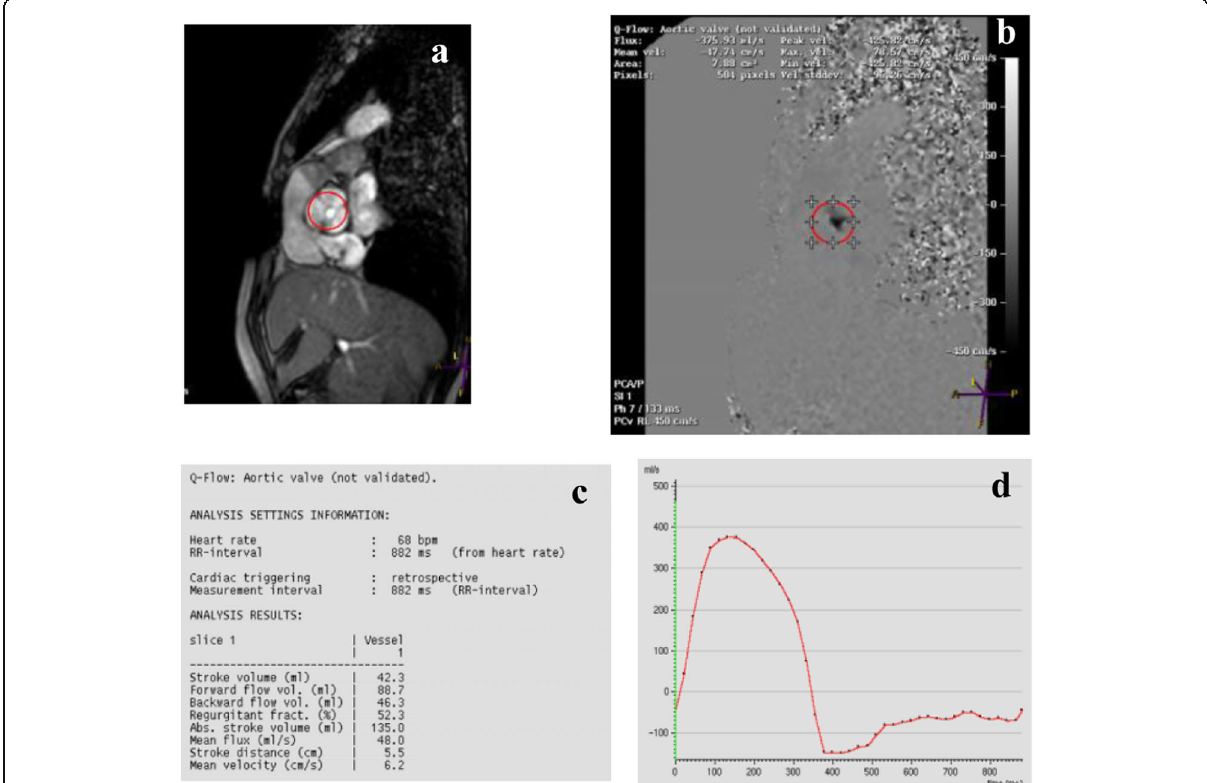
Fig. 9 On the other hand, the same patient using the phase-contrast analysis, the LV stroke volume (SVPC) was 42.3 ml and ejection fraction (EFPC) was (42.3/245.1) × 100 = 17.3% (severe dysfunction). a The magnitute image showing the detailed anatomy, contour, and the shape of the aorta. b The phase velocity map depicts the velocity and direction of flow in each pixel within the aortic valve during systole. c Q-flow analysis of the aortic flow. d By outlining the contours of the aorta throughout each phase in the cardiac cycle, a flow curve can be generated to